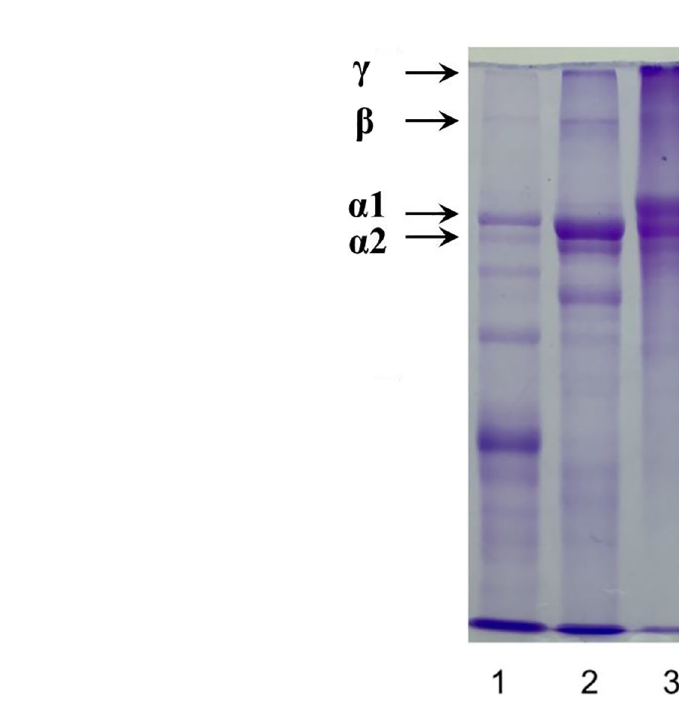
FIGURE 2 | SDS-PAGE gel electrophoresis of cartilage gelatin from Siberian sturgeon and pigskin gelatin. Lane 1, sturgeon cartilage gelatin; lane 2, sturgeon cartilage collagen; lane 3, pigskin gelatin; 4, protein